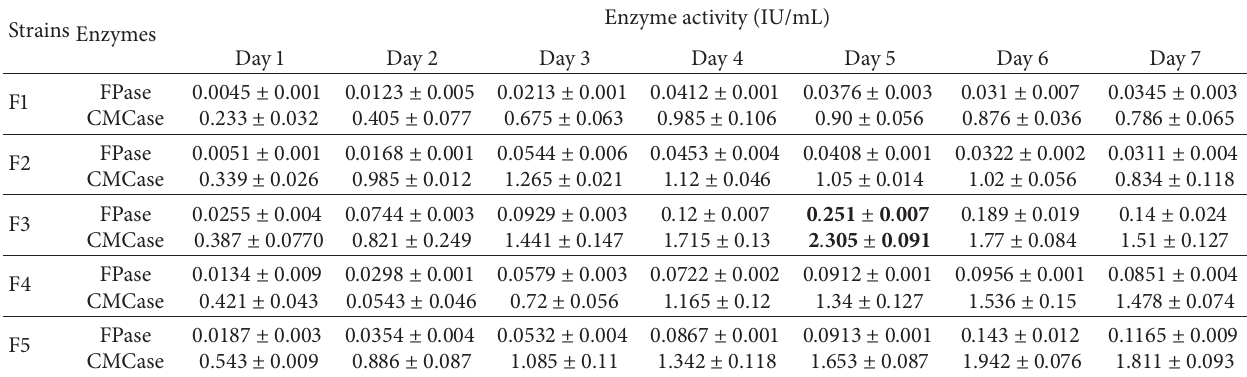
Table 1: FPase and CMCase activities of fungal isolates. Results are presented as the mean of three replicates with standard deviation. Strains